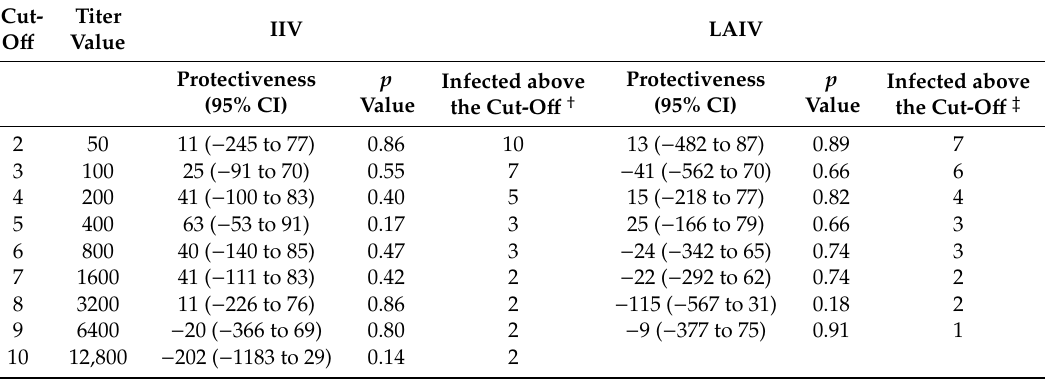
Table 5. Protectiveness of serum IgA against H3N2.